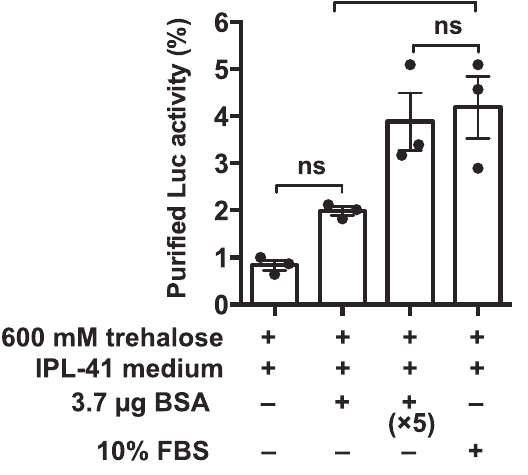
Figure 5. Enzyme activity of recombinant luciferase after dehydration in vitro . Emerald luciferase (370 ng) diluted into 40 µ L of a 600 mM trehalose solution containing either BSA, FBS or nothing was dehydrated for 7 days. The 3.7- µ g BSA condition is represented as a molar ratio of 10:1 (BSA/Luc). Luciferase activity was measured after rehydration. Each value is shown as a scatter dot plot. Error bar shows standard error of mean (n = 3). Statistical significance was calculated by using one-way ANOVA and Tukey’s multiple comparison test as a post hoc analysis (“ * ” means significantly different p = 0.002; “ns” means not significantly different).